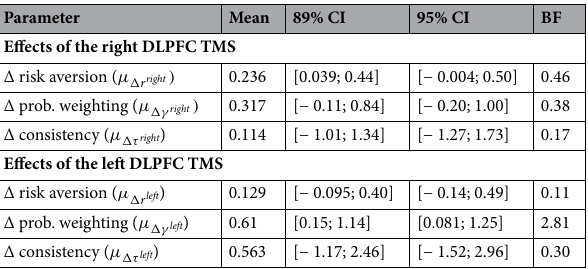
Table 5. Summary the DLPFC TMS effects on risk preference parameters in the gain domain : mean, 89% and 95% CIs, and the Bayes Factor. The Bayes factor indicates evidence in favor of H 1 : δ �= 0 against H 0 : δ = 0